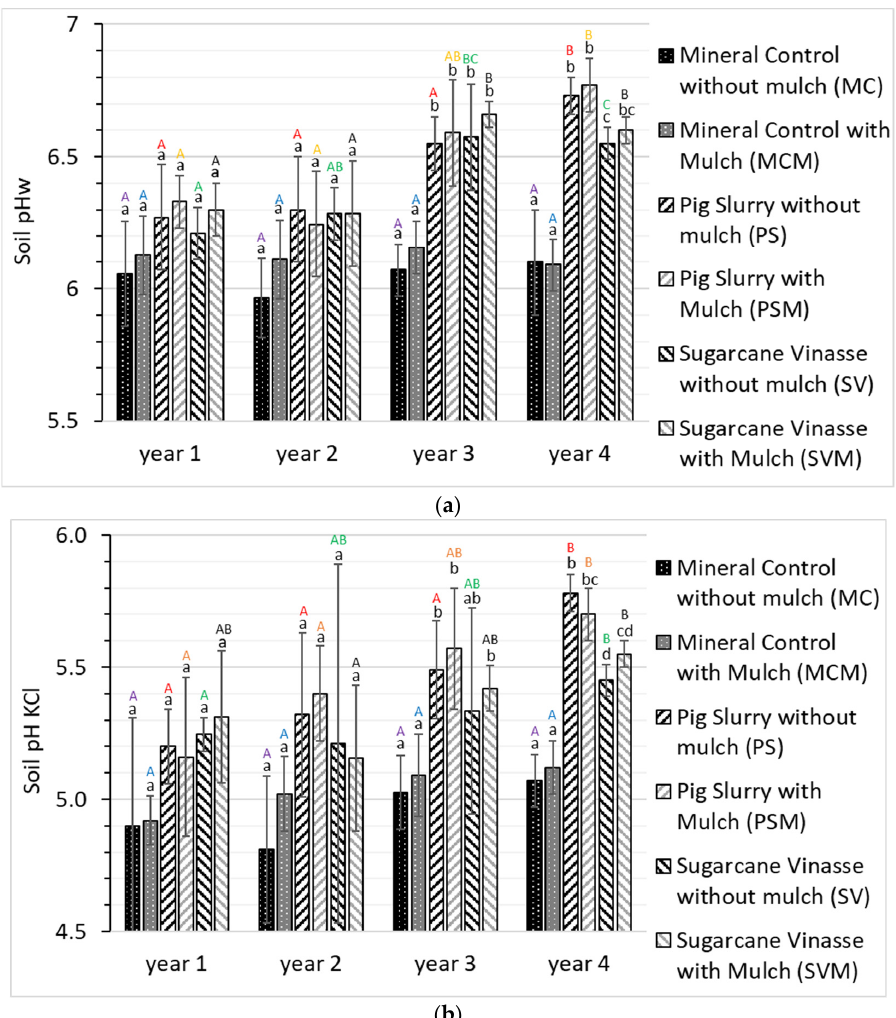
Figure 2. Soil pHw ( a ) and soil pH KCl ( b ) under each treatment in the four years. Error bars correspond to the standard deviation between replicates for each treatment. Identical letters indicate no significant differences between two modalities in a given year. Lower case letters compare treatments for the given year and capital letters compare treatments between the years.